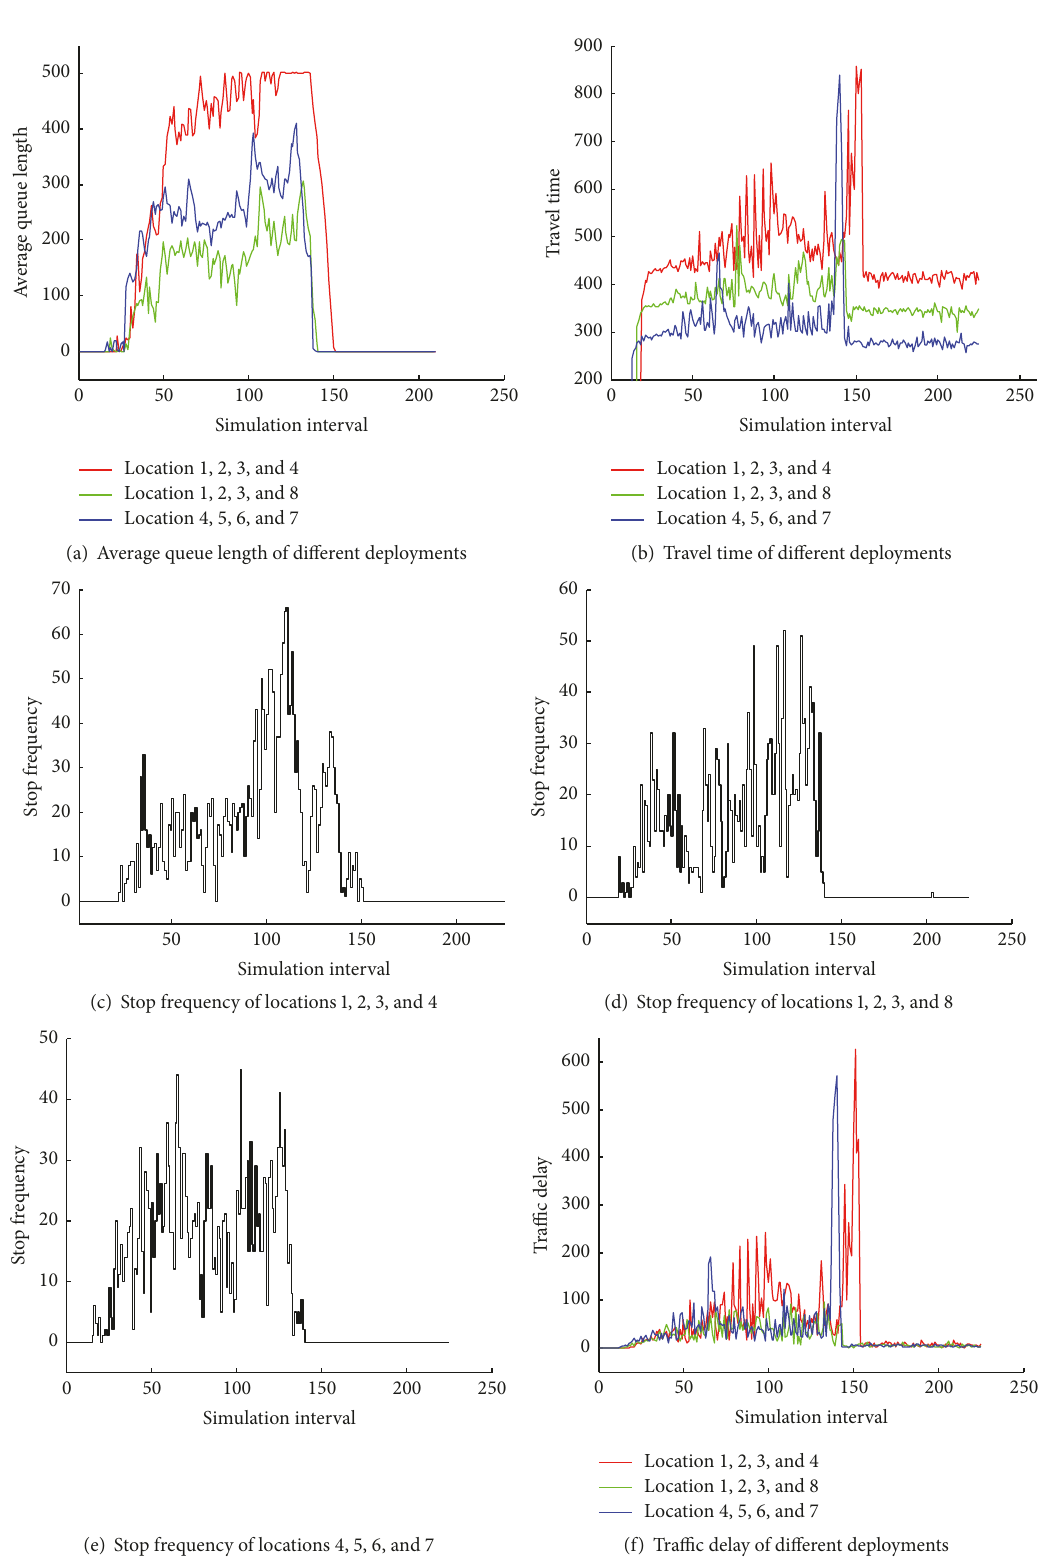
Figure 13: Evaluation results of different